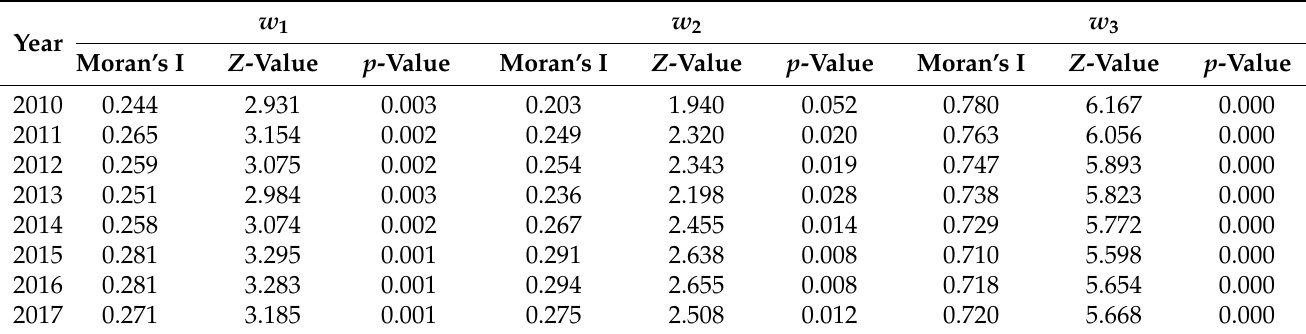
Table 2. Moran’s I of green technology innovation in 30 provincial administrative regions from 2010 to